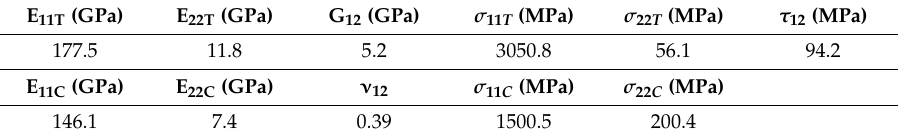
Table 1. Stiffness and strength properties of the M21E/IMA carbon fibre/epoxy system [3,5].